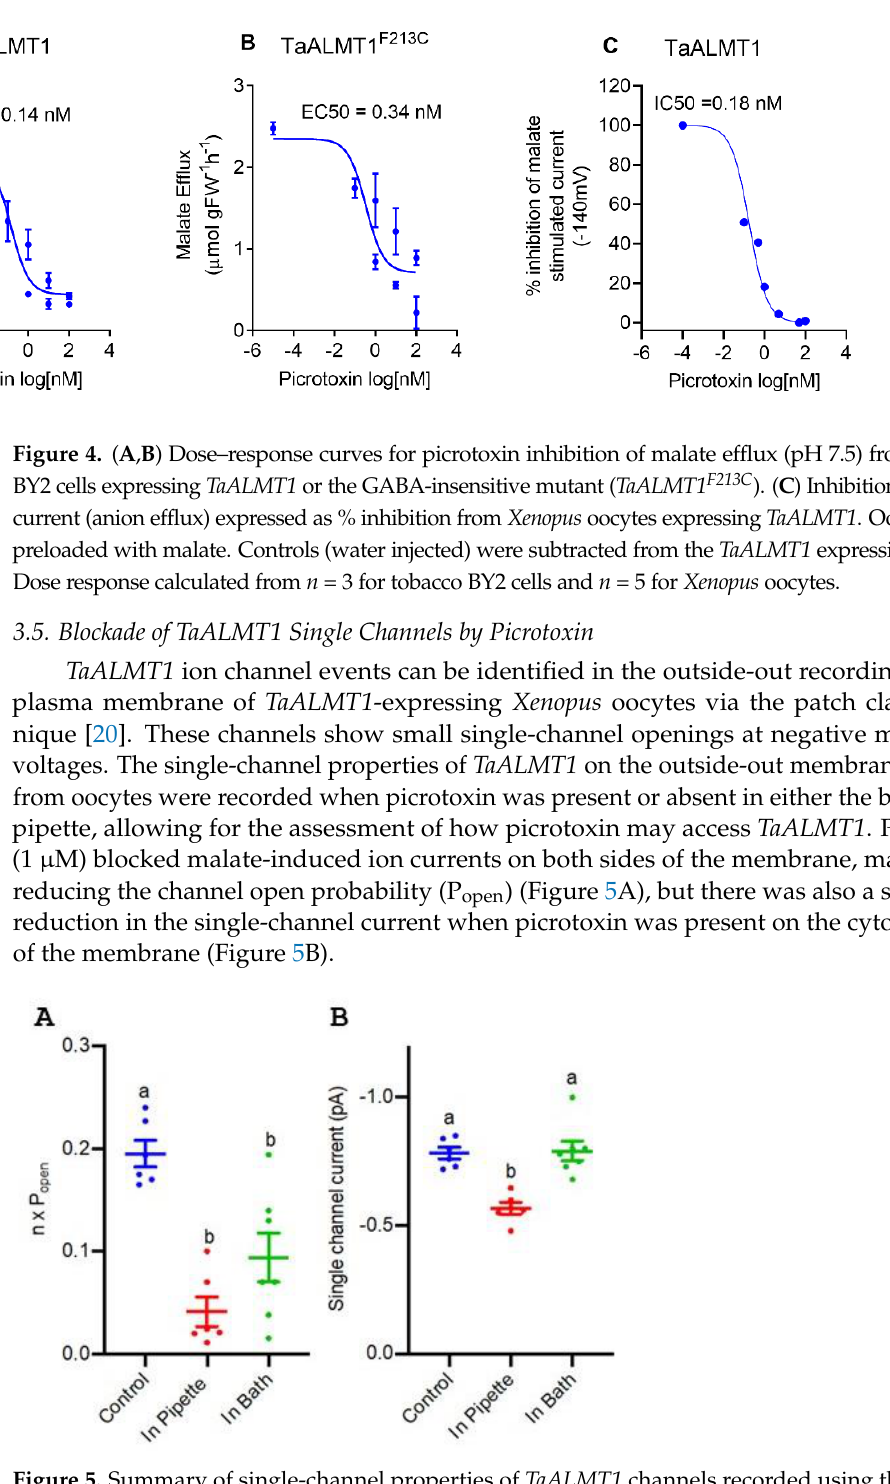
Figure 5. Summary of single-channel properties of TaALMT1 channels recorded using the outside- out patch clamp technique on the plasma membrane of TaALMT1- expressing Xenopus oocytes. ( A ) Number of channels multiplied by the channel open probability (n x P open ). ( B ) Single-channel amplitude at − 160 mV with 35 mM: 25 mM malate (pipette:bath), pH = 7.2 (HEPES /Tris). Each point represents a single oocyte recording. Mean and SE are shown. Different letters represent significant differences between treatments using one-way ANOVA.